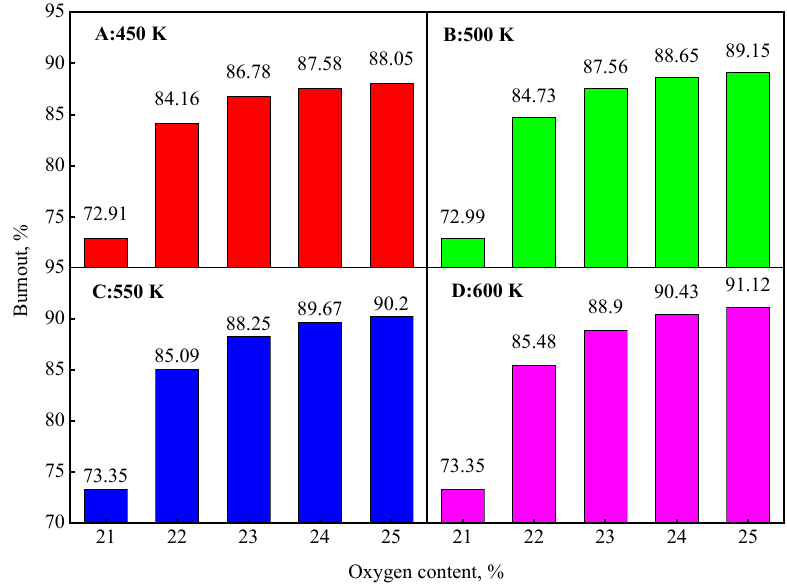
tion process was enhanced, which became more obvious with an increase in the coal particle temperature. The hysteresis of the coal combustion process caused by the room-temperature oxygen disappeared with an increase in the coal particle temperature. This is because the heat of coal particles makes up for the cooling effect of room-temperature oxygen. The coal particles had more time to combust, meaning the Figure 14. Final coal burnout under co-enhancement of heat and oxygen. Figure 14. Final coal burnout under co-enhancement of heat and oxygen. coal burnout quickly increased under sufficient oxygen. To further understand the effect of coal particle temperature, the coal burnout at different positions was investigated, as shown in Figure 15. In general, the coal combus-